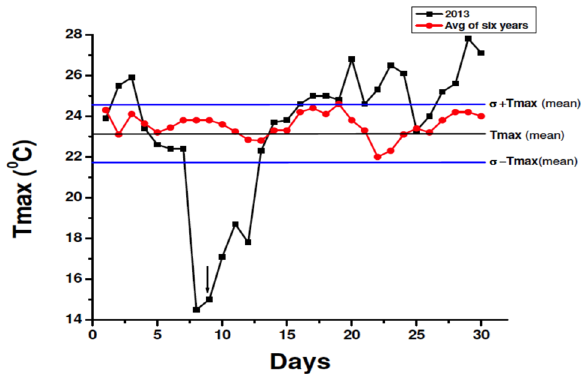
Figure 7. Six years average maximum temperature variation (Tmax) for January along with that for January 2013, observed over Guwa- hati. Note the large drop in temperature prior to the January 2013 EQ. The EQ day is marked by an arrow head. The standard devia- tion magnitude of Tmax from the average values is shown by thick blue